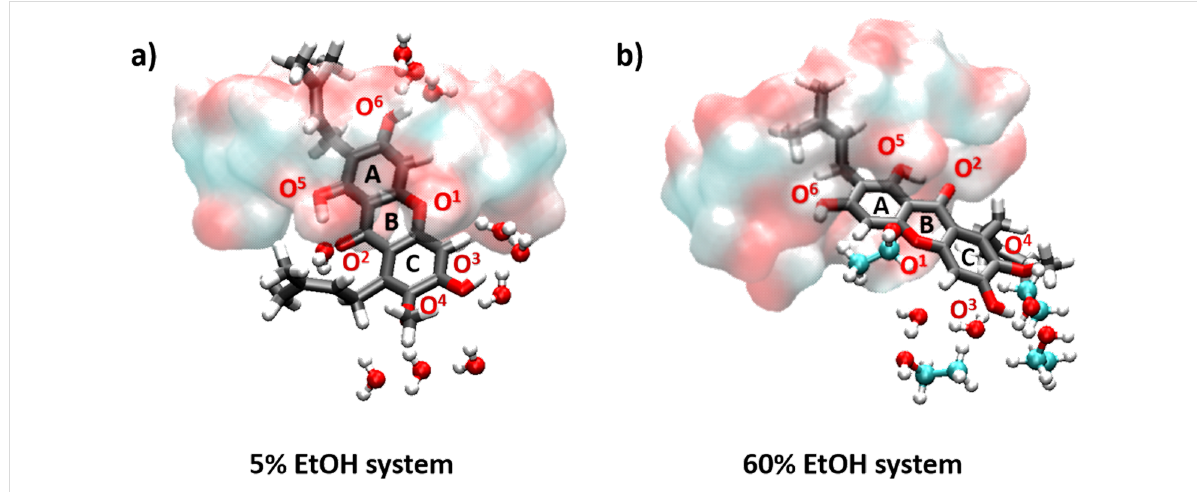
Figure 7: Snapshots of solvation around heteroatoms of α -MGS/ β -CD for systems containing 5% and 60% v/v ethanol.